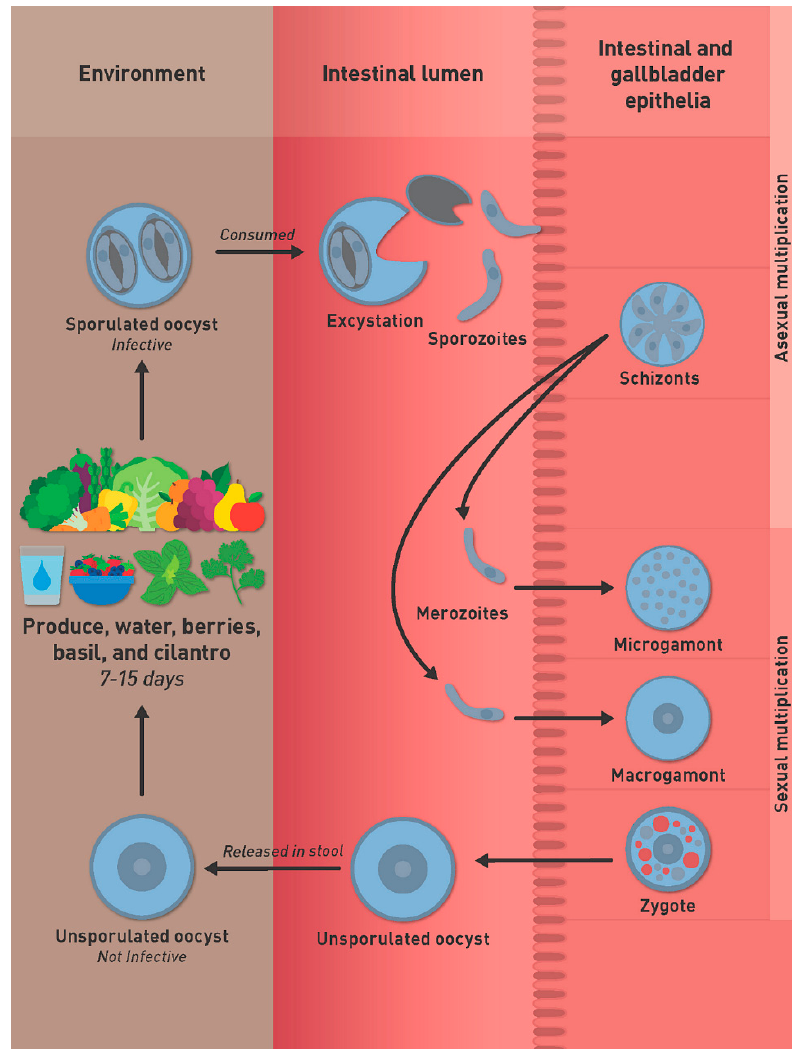
Figure 1. Proposed life cycle of Cyclospora cayetanensis. If a susceptible human ingests sporulated oocysts in contaminated food or water, the sporozoites inside the sporocysts excyst in the gut lumen and invade intestinal-biliary epithelial cells where the sporozoites transform into schizonts. Sexual multiplication occurs at the same site as asexual cycle. Microgamonts (male) contain flagellated